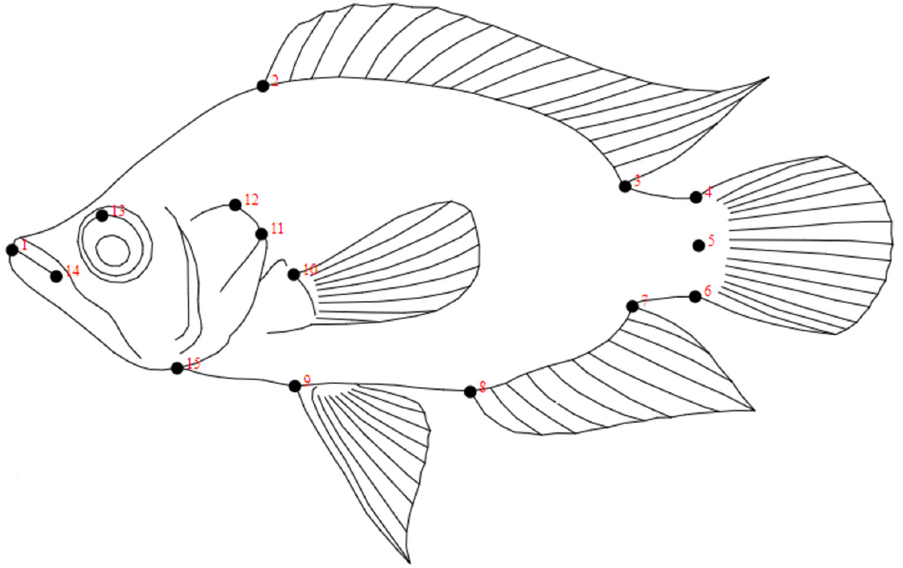
Figure 2. Graphical representation of C. kraussii showing the locations of 15 landmarks following Hernandez et al. [39].